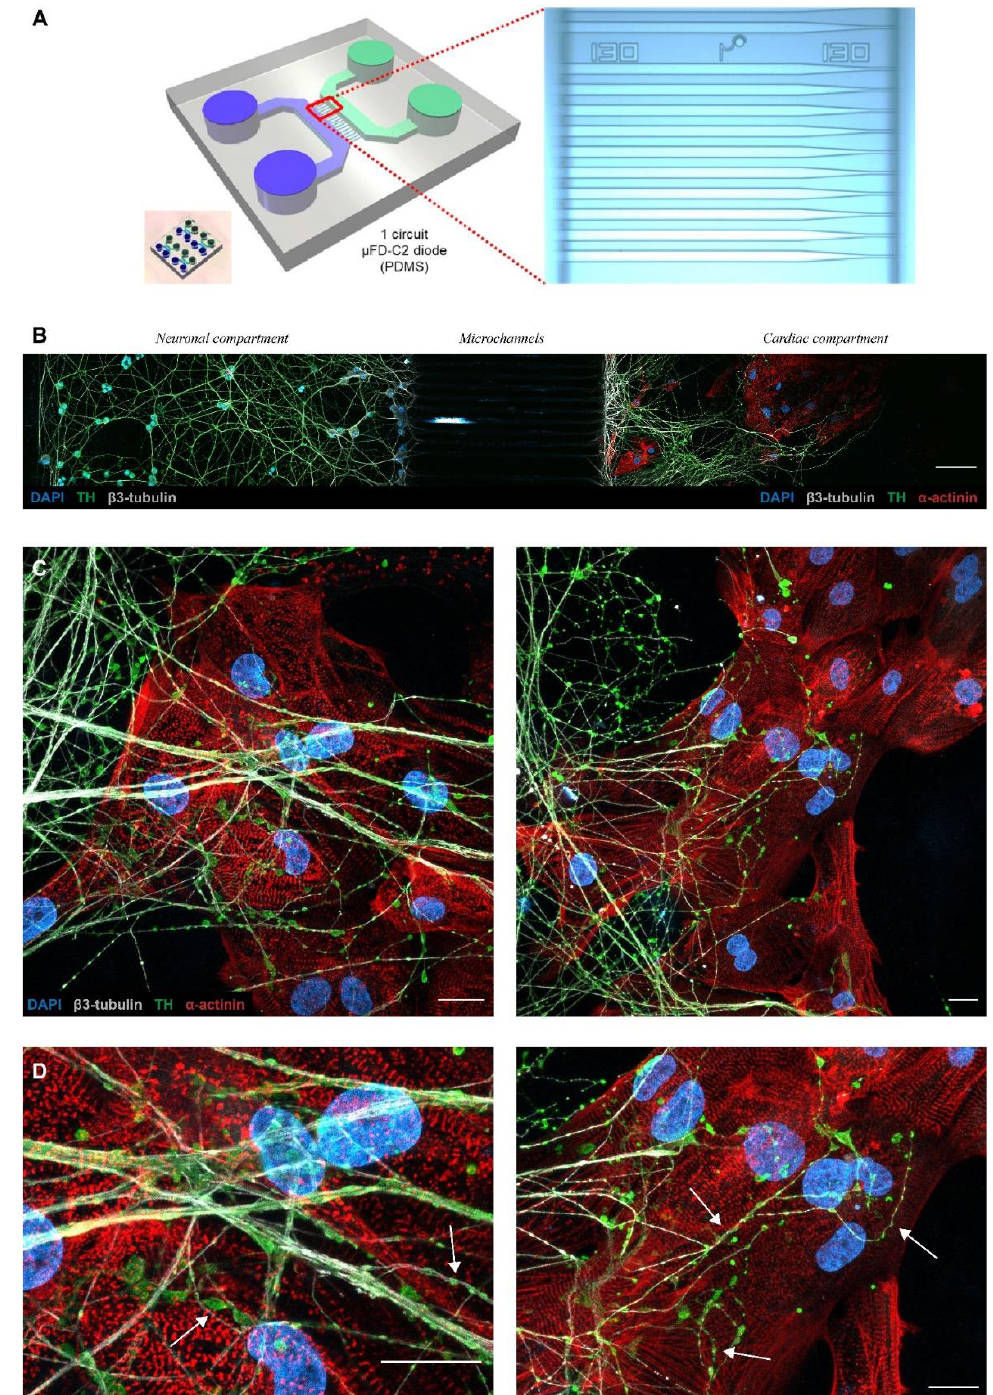
Figure 2. Neuronal diodes fluidic microsystems as tools to establish compartmentalized neurocardiac co-culture on chip. ( A ) Structural characteristics of a two-chamber neuronal diode also known as Brainies ® . Left panel : 3D model of the micro-structured PDMS-based block (grey), including cylindric wells (diameter: 4 mm; height: 5 mm), rectangular cell culture chambers (vol. ~1 µL; height: 55 µm), and a series of asymmetrical microchannels (length: 500 µm; height: 3 µm; width: tapering from 15 µm to 3 µm). The compartment where neurons are seeded is represented in blue and the compartment where cardiomyocytes are seeded is represented in green. The small insert shows a picture of one of the Brainies ® that contains four neuronal diodes. Right panel : micro-graph of a portion of the funnel-shaped microchannels. ( B ) In this fluorescence microscopy image of a microfluidic chip section, the neural compartment is located to the left and the cardiac compartment to the right. Between the two compartments are the microchannels (not visible in the image, scale bar: